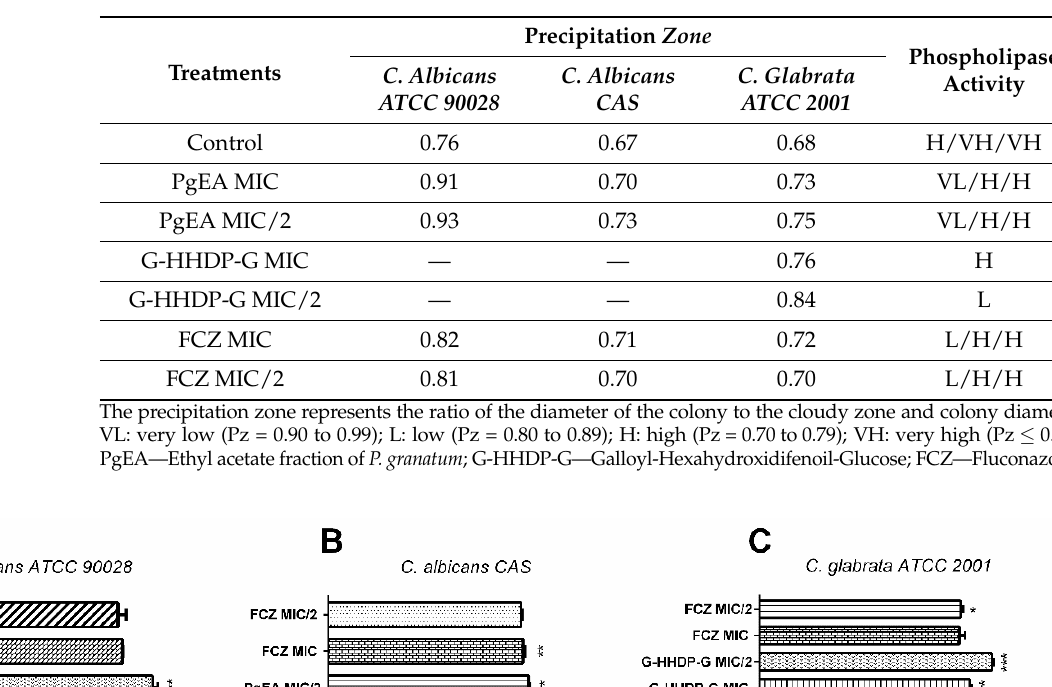
Table 6. Candida spp. extracellular phospholipase activity when treated with PgEA, G-HHDP-G, and FCZ, as evaluated in egg yolk medium in terms of the precipitation zone.